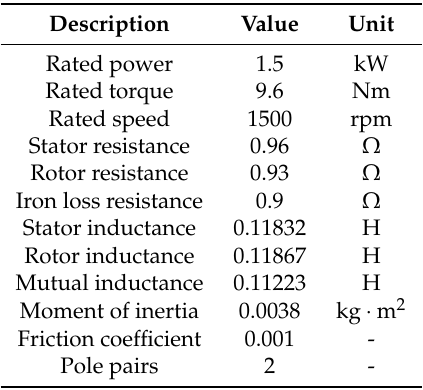
Figure 5. Overall structure of the experiment. Table 1. Parameters of